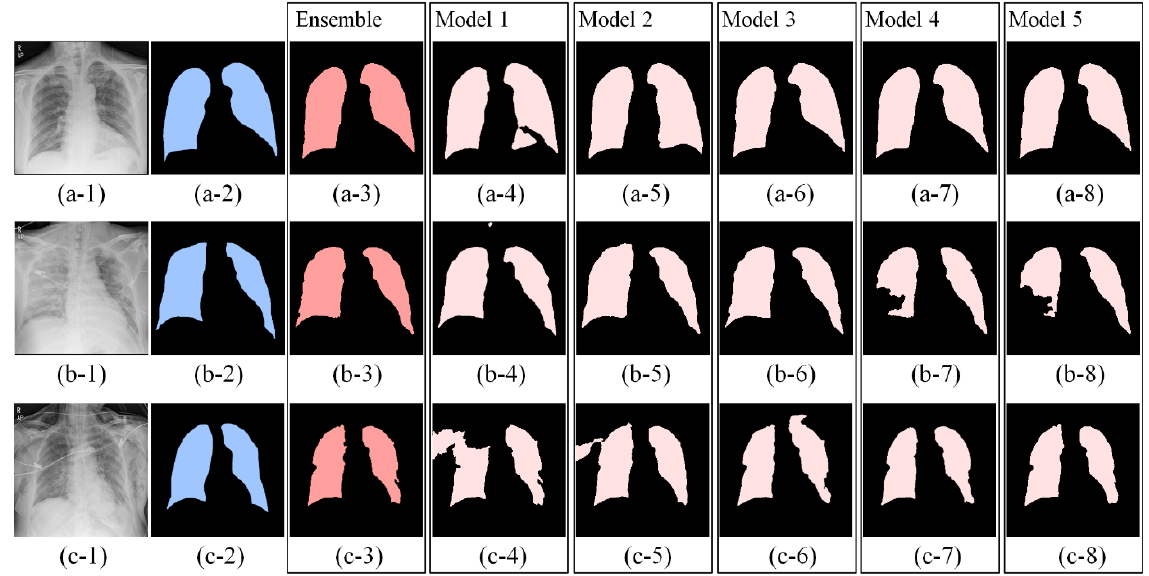
Figure 3. An example of advantages of the ensemble method for different quality of CXRs. The first to last row in each column shows an input CXR ( a,b,c-1 ), a ground truth mask ( a,b,c-2 ), an ensemble result ( a,b,c-3 ), and five results predicted by the first to fifth model. ( a-1 ) A clear CXR that shows none of severe noise from a portable device and obstacles like medical devices, ( b ) a lung mask of ( a-1 , a-3 ) an ensemble mask from the first to the fifth masks ( a-4 – a-8 ). Dice coefficients of ( a-3 – a-8 ) are 0.955, 0.928, 0912, 0.948, 0.948, and 0.948, respectively. (i) An CXR showing severe blurry within both lung regions due to lung opacity, ( b-2 ) a lung mask of ( b-1 , b-3 ) an ensemble mask from the first to the fifth masks ( b-4 – b-8 ). Dice coefficients of ( b-3 – b-8 ) are 0.955, 0.928, 0912, 0.948, 0.948, and 0.948, respectively. ( c-1 ) An CXR showing sever noise generated from a portable device, ( c-2 ) a lung mask of ( c-1 , c-3 ) an ensemble mask from the first to the fifth masks ( c-4 – c-8 ). Dice coefficients of ( c-3 – c-8 ) are 0.899, 0.783, 0.885, 0.883, 0.879, and 0.903, respectively.